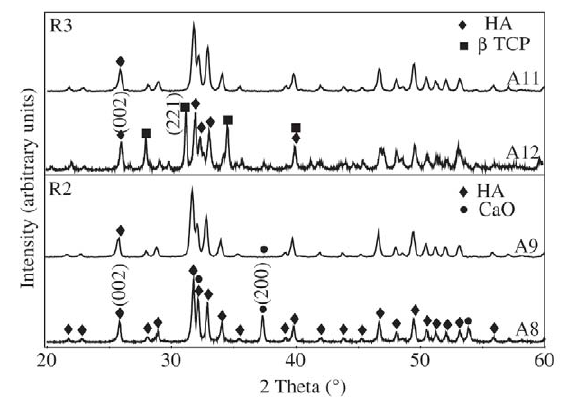
Figure 7. Graphic representation of phase contents measured by the relative intensities of (002) HA lattice planes and (200) CaO lattice planes in XRD patterns of synthesized hydroxyapatite after thermal treatment on R1 samples (A) and R2 samples (B); and (002) HA lattice planes and (221) β -TCP lattice planes on R3 sam- ples (C).